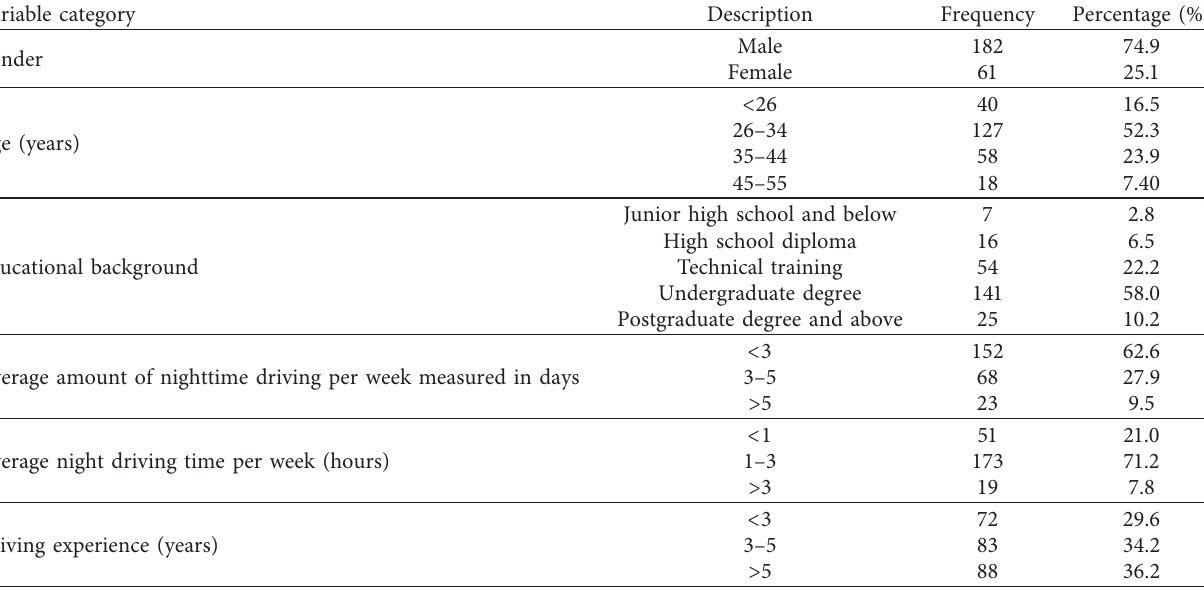
Table 5: Sample characteristics ( n �